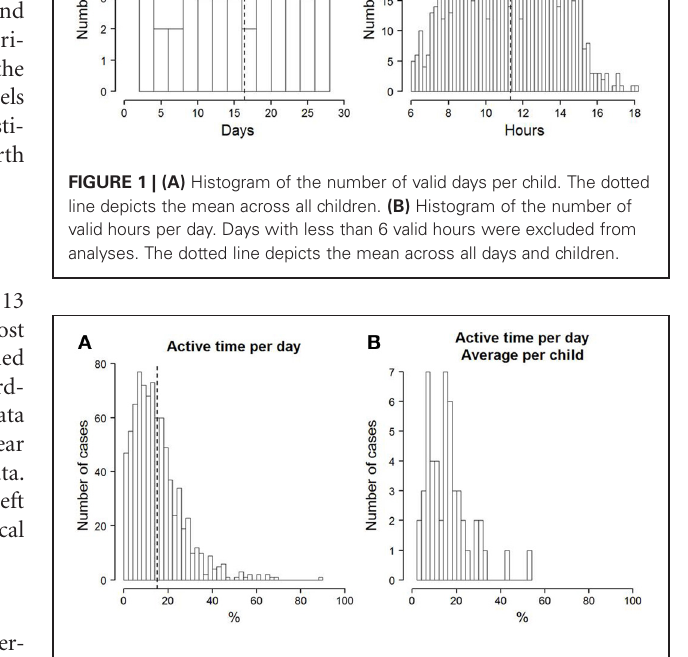
FIGURE 2 | (A) Histogram of the percentage of time per day that children were physically active. The dotted line depicts the mean across all days and children. (B) Histogram of each child’s mean percentage of time per day spent with